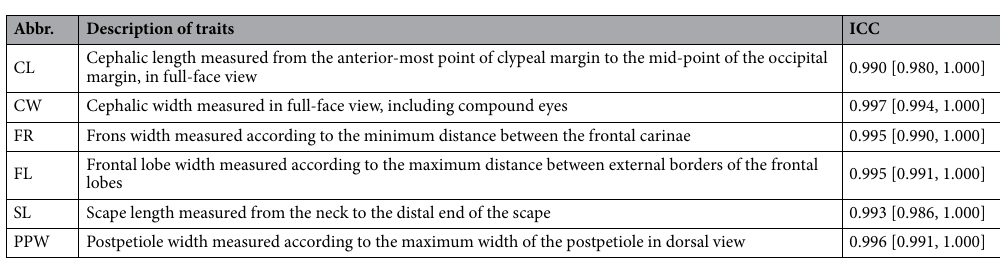
Table 1. Verbatim trait definitions for morphometric character recording. Abbreviation (Abbr.), verbatim character definition and intraclass correlation coefficients (ICC) of certain morphometric traits are provided. Upper and lower bounds of ICC scores, separated by a coma, are also given in parentheses.